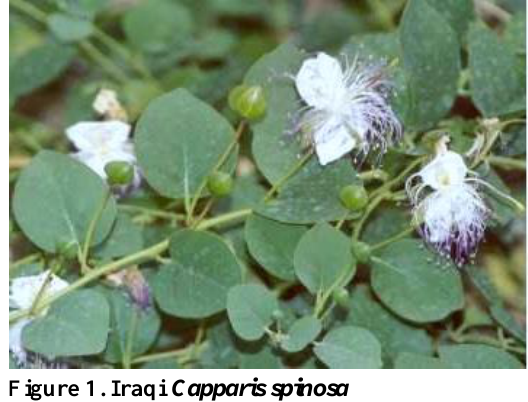
Figure 1. Iraqi Capparis